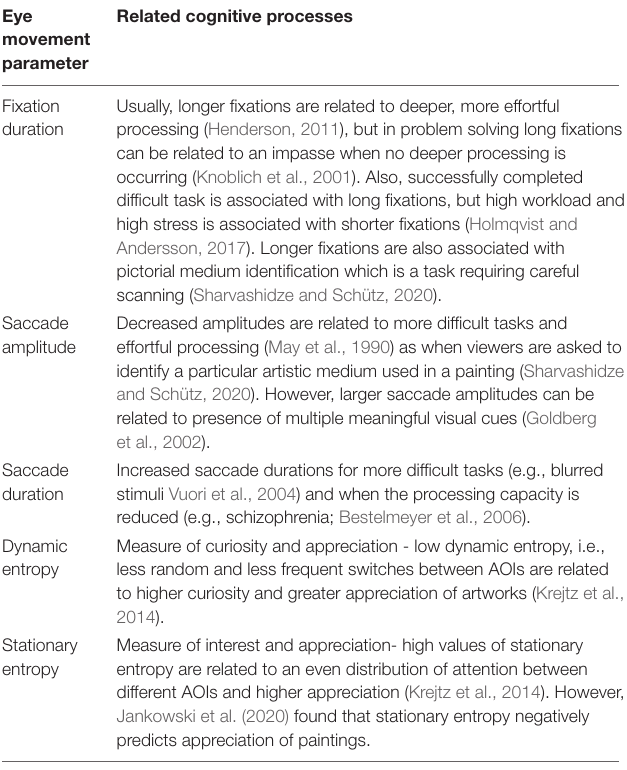
TABLE 1 | Relationship between selected eye movement parameters and cognitive